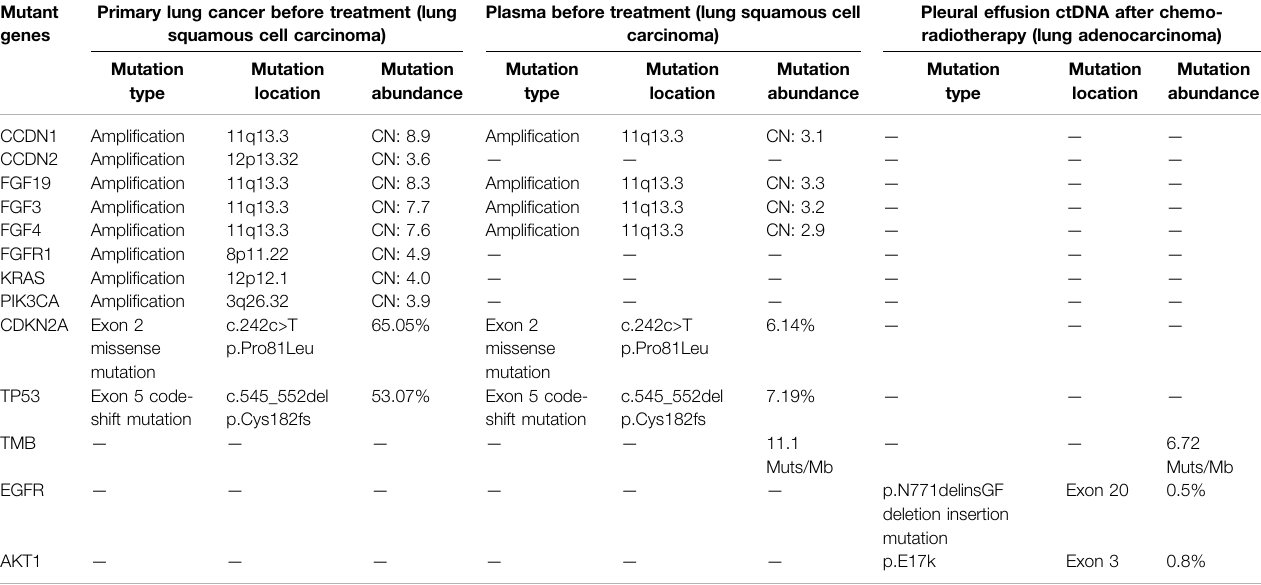
TABLE 1 | Next-generation sequencing results of pulmonary biopsy and plasma before treatments and of pleural fl uid – exfoliated cells after chemoradiotherapy. Mutant Primary lung cancer before treatment (lung Plasma before treatment (lung squamous cell Pleural effusion ctDNA after chemo- genes squamous cell carcinoma) carcinoma) radiotherapy (lung